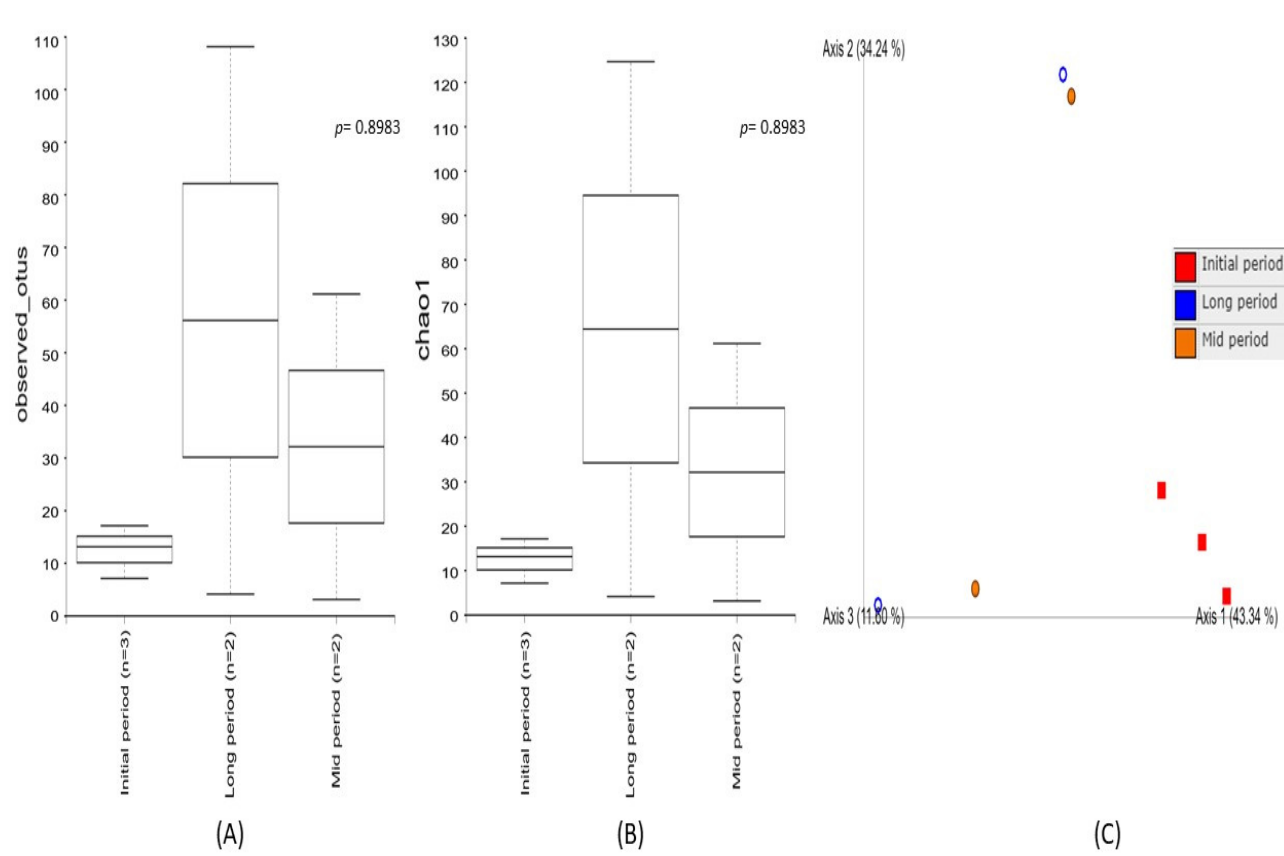
Figure 2. Comparison of bacterial community diversity among the samples collected at the initial, mid, and long periods after volcanic eruption. Box plot of the alpha diversity indices ( A ) Observed_OTUs and ( B ) Chao1 based on 16S rRNA gene amplicon sequencing, demonstrating a higher diversity richness in long-period samples, followed by the mid- and initial-period samples. The line inside the box represents the median, while the whiskers represent the lowest and highest values within the 1.5 interquartile range (IQR). ( C ) Principal coordinate analysis (PCoA) of beta diversity among the samples collected at the initial, mid, and long periods after the volcanic eruption, evidencing a higher variation among the samples.